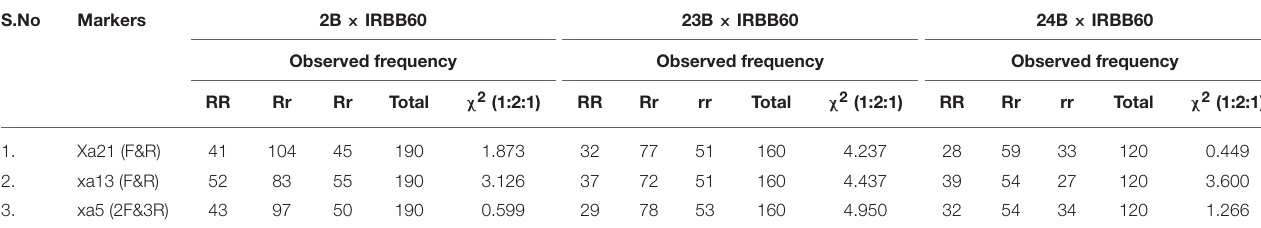
RR, rr,Homozygotes; Rr, Heterozygote.